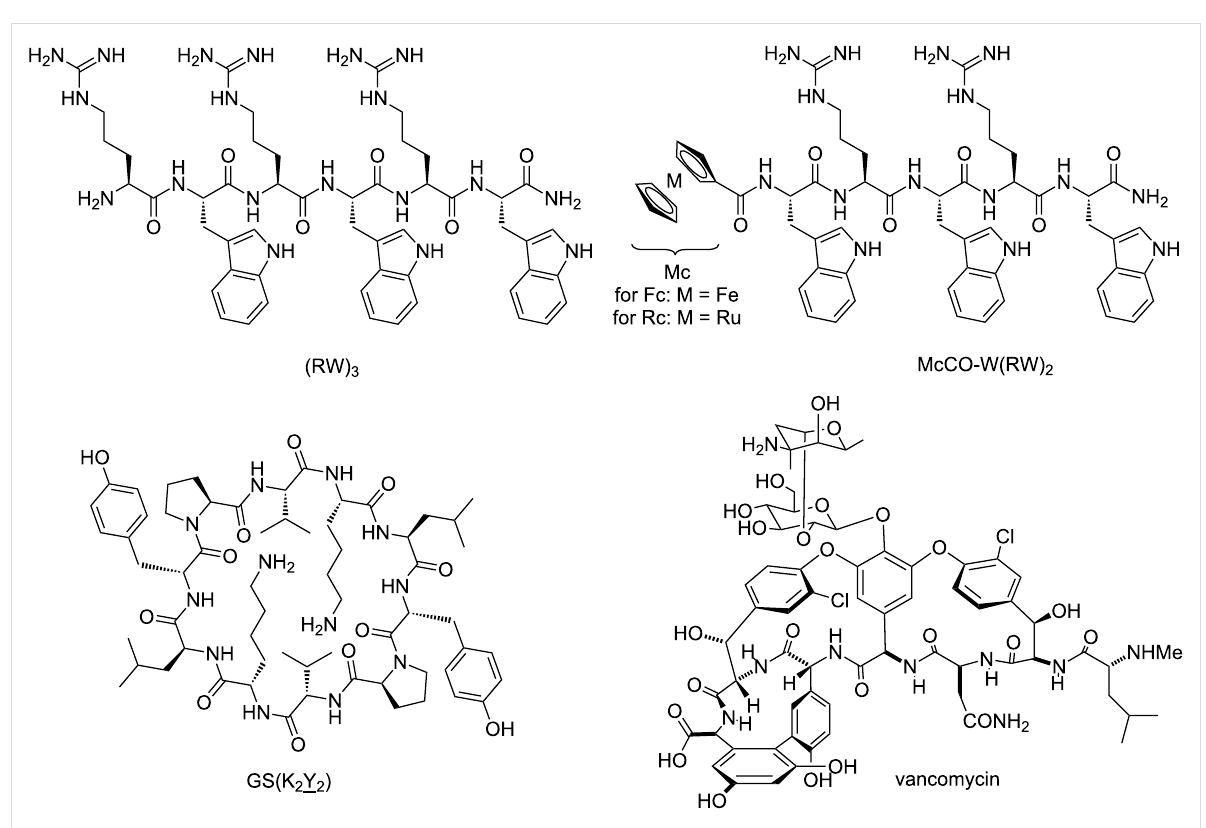
Figure 1: Structures of the most active peptides that have been used in this study. The top row shows two representative structures of the Arg-Trp based peptides (left) and their metallocene-derivatives (right); the lower row shows the structure of pore-forming gramicidin S derivative GS(K 2 Y 2 ) (left) and lipid II-binding cell wall biosynthesis inhibitor vancomycin (right).